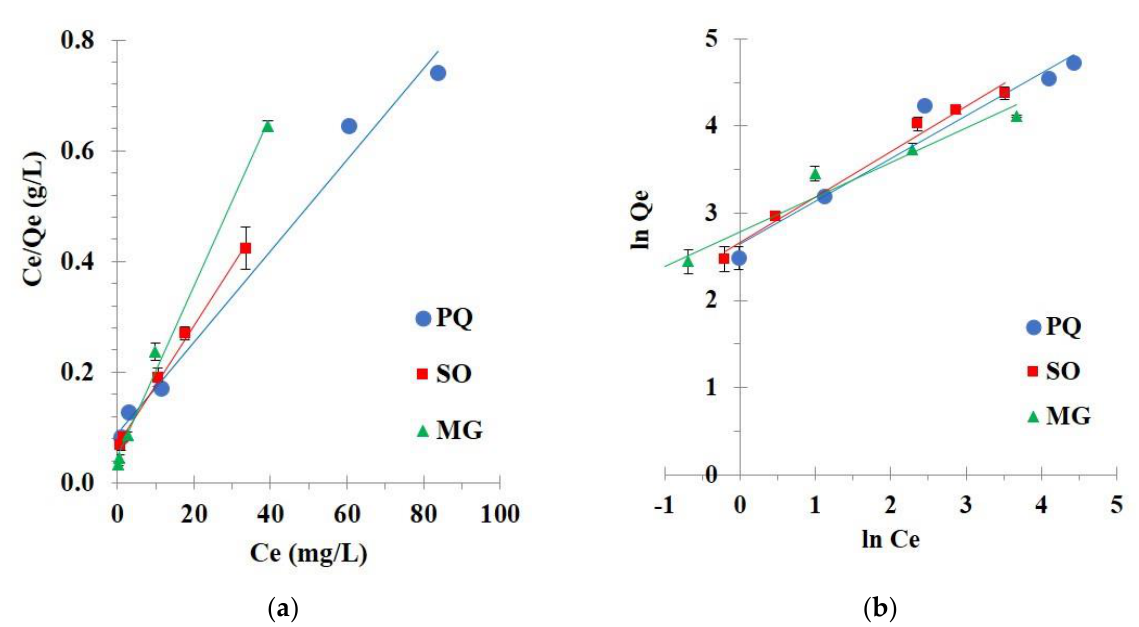
11b) isotherm models were applied to the experimental data to evaluate the linearity of